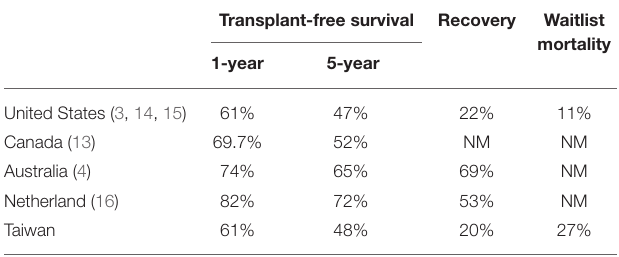
TABLE 4 | Comparisons of transplant-free survival rates, recovery rates, and waitlist mortality rates among western countries and the present Asian cohort. Transplant-free survival Recovery Waitlist